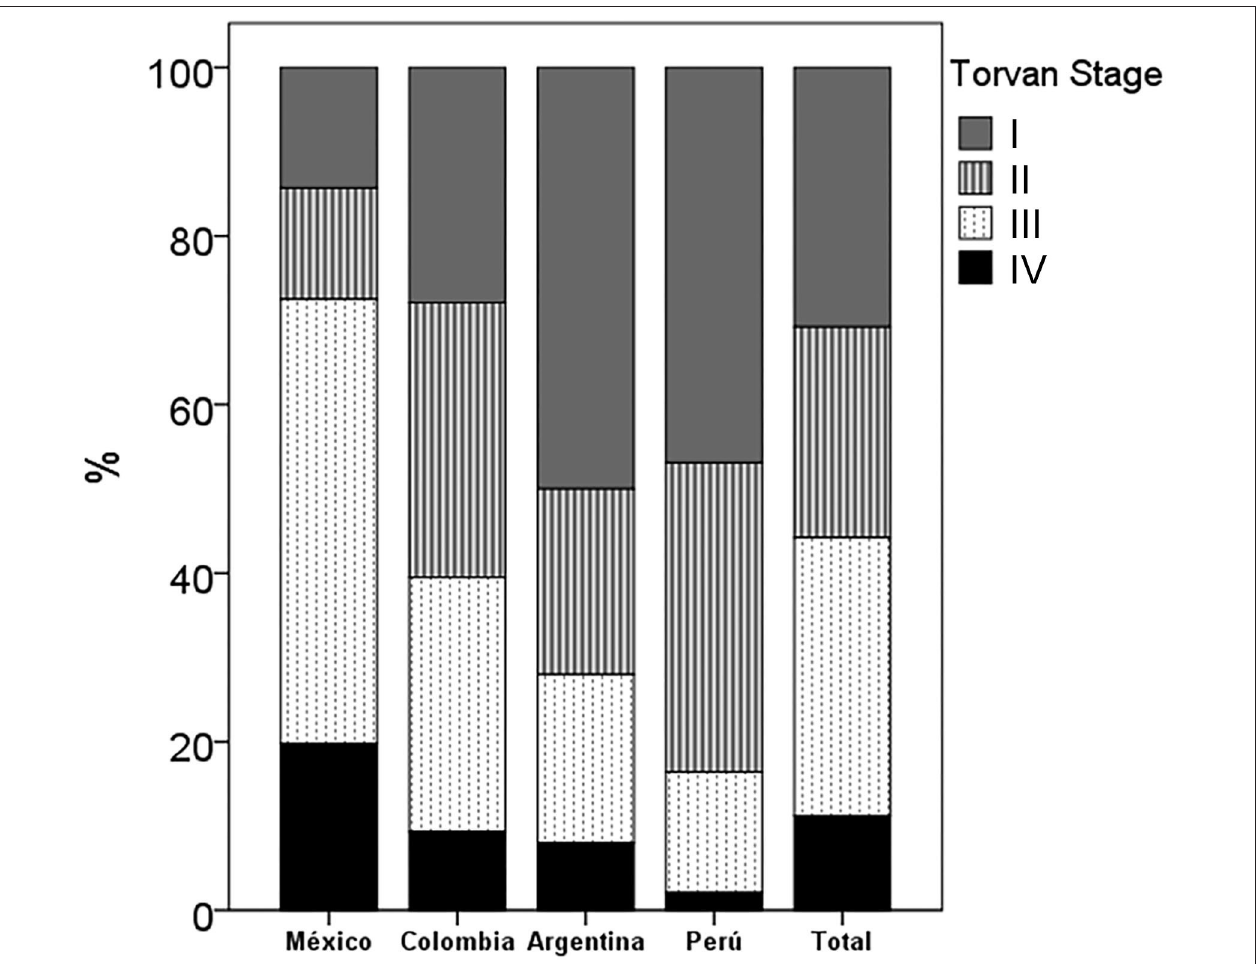
FIGURE 3 | Proportion of patients in the TORVAN states in the total group and in each country. In Mexico, there were more patients in stages III-IV and in Argentina, Colombia and Peru in stages I-II ( p <